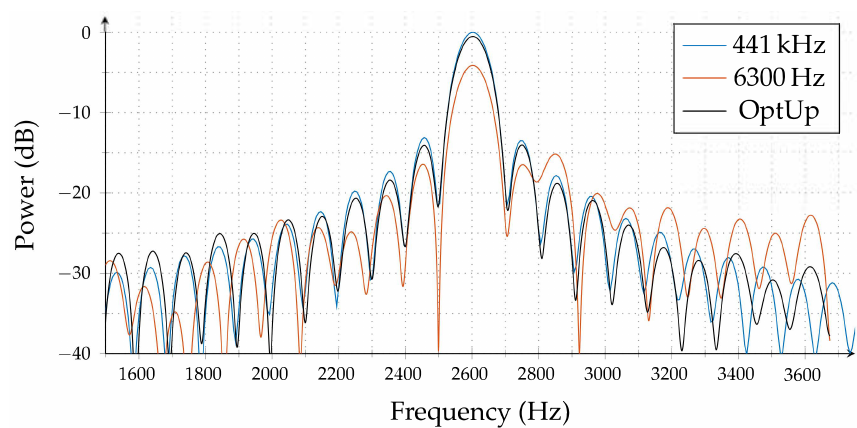
Figure 6. Experimental measurement-based comparison of standard interpolation (6300 Hz) vs. optimal upsampling approach